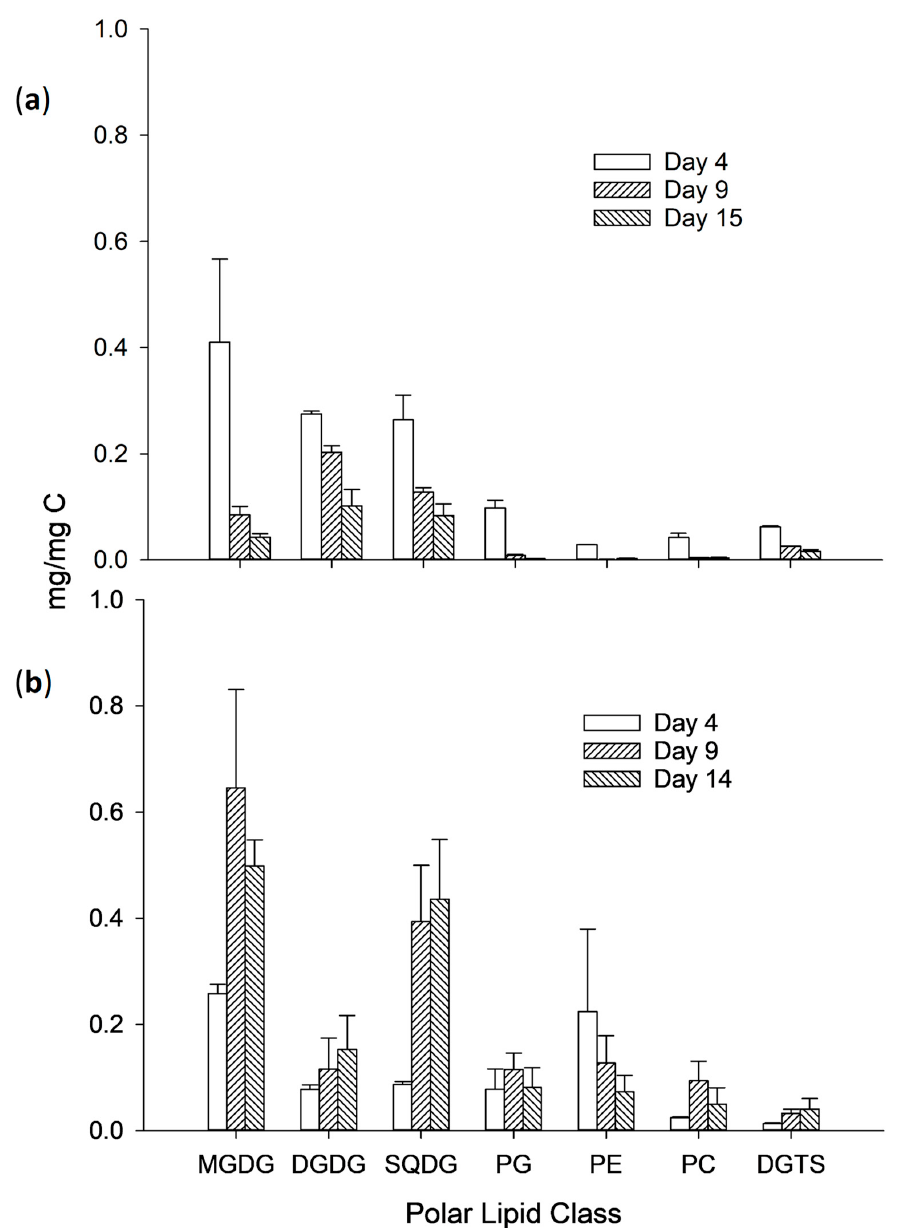
Figure 3. Polar lipid class concentrations in Chlorella sp. Biomass grown in batch cultures containing either ( a ) LN or ( b ) HN media (sampling day legend inset). Lipid classes were as follows: monogalactosyldiacylglycerol (MGDG); digalactosyldiacylglycerol (DGDG); sulfoquinovosyldiacylglycerol (SQDG); phosphatidylcholine (PC); phosphatidylglycerol (PG); phosphatidylethanolamine (PE), diacylglyceryl trimethyl homoserine (DGTS).